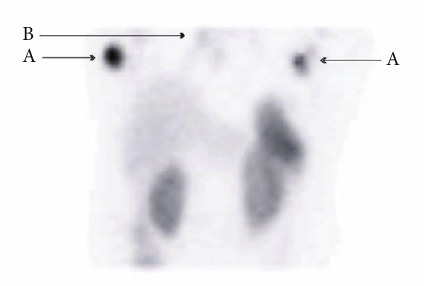
Figure 1: Whole body 111-In-octreotide scintigraphy showing uptake in both breasts (A), complementary to a mediastinal lesion